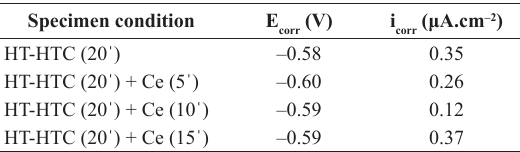
and i in 0.01 M NaCl. corr corr